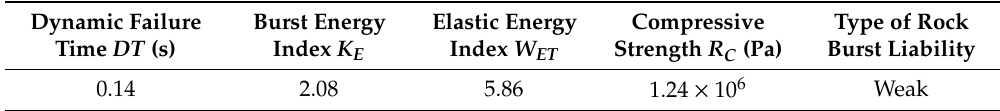
Table 1. Rockburst liability test parameters of the No. B3 + 6 coal seam.